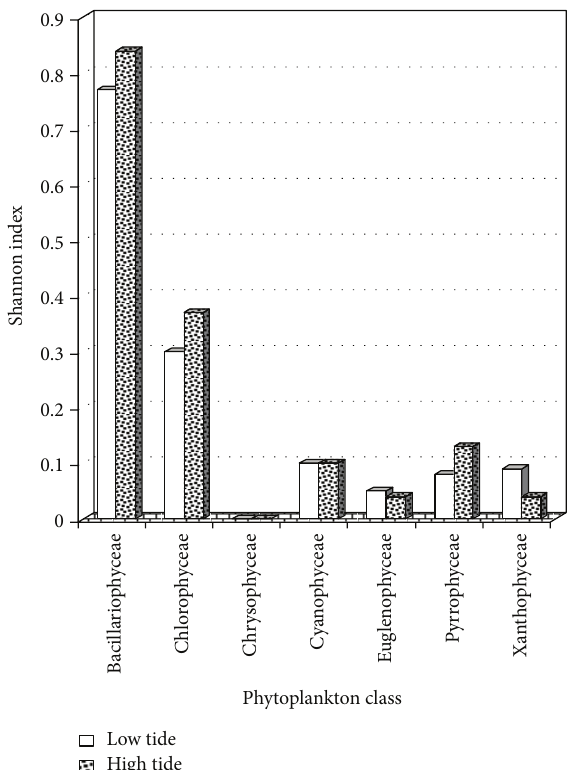
Figure 5: Variation of phytoplankton Shannon index. Variations of phytoplankton parameters in relation to tide in Okpoka Creek.